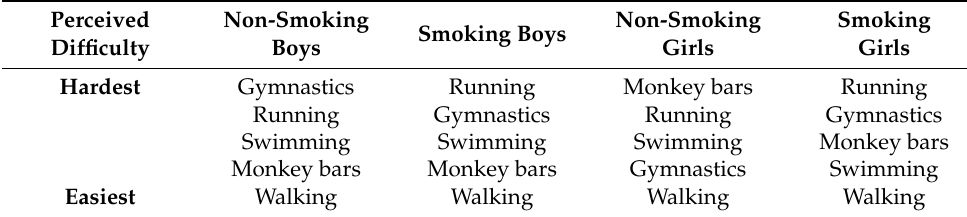
Table 2. Activities ranked in overall order of ‘hardest’ to ‘easiest’ as described by participating children by household smoking status and